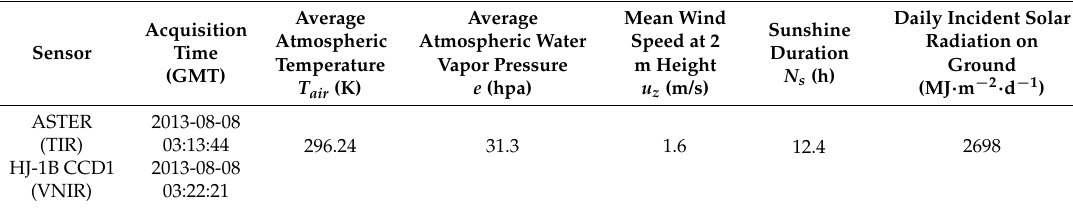
Table A2. Parameters of satellite image data and meteorological data for Wuhan testing